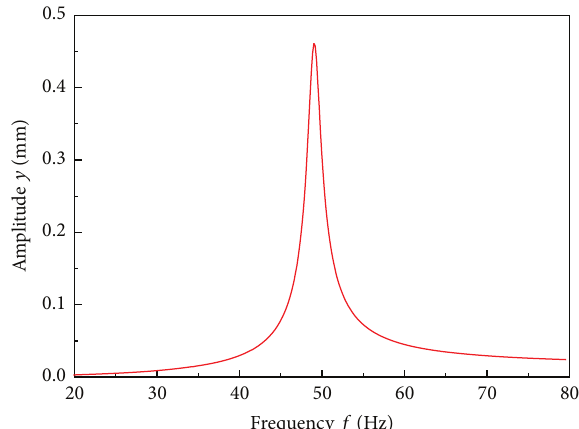
Figure 7: Responses of the rotor system.